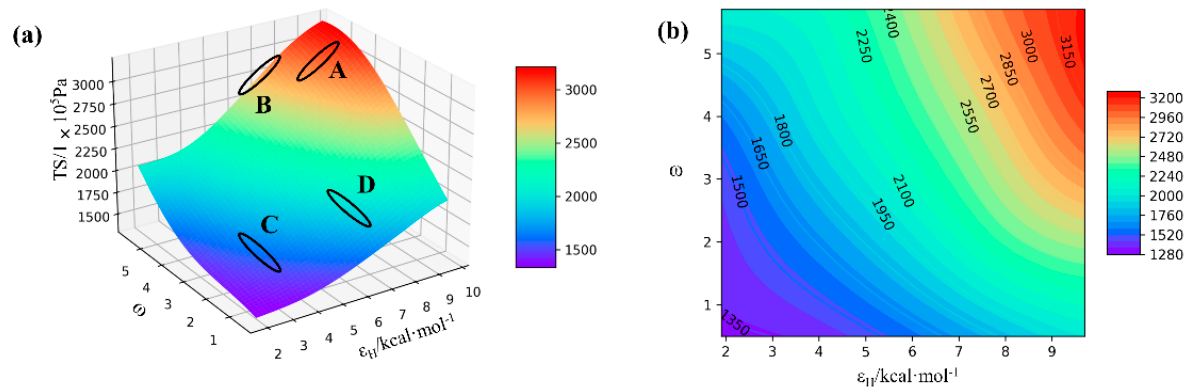
Figure 8. ( a ) MD-XGB predicted 3D image; ( b ) contour map of the predicted 3D image.